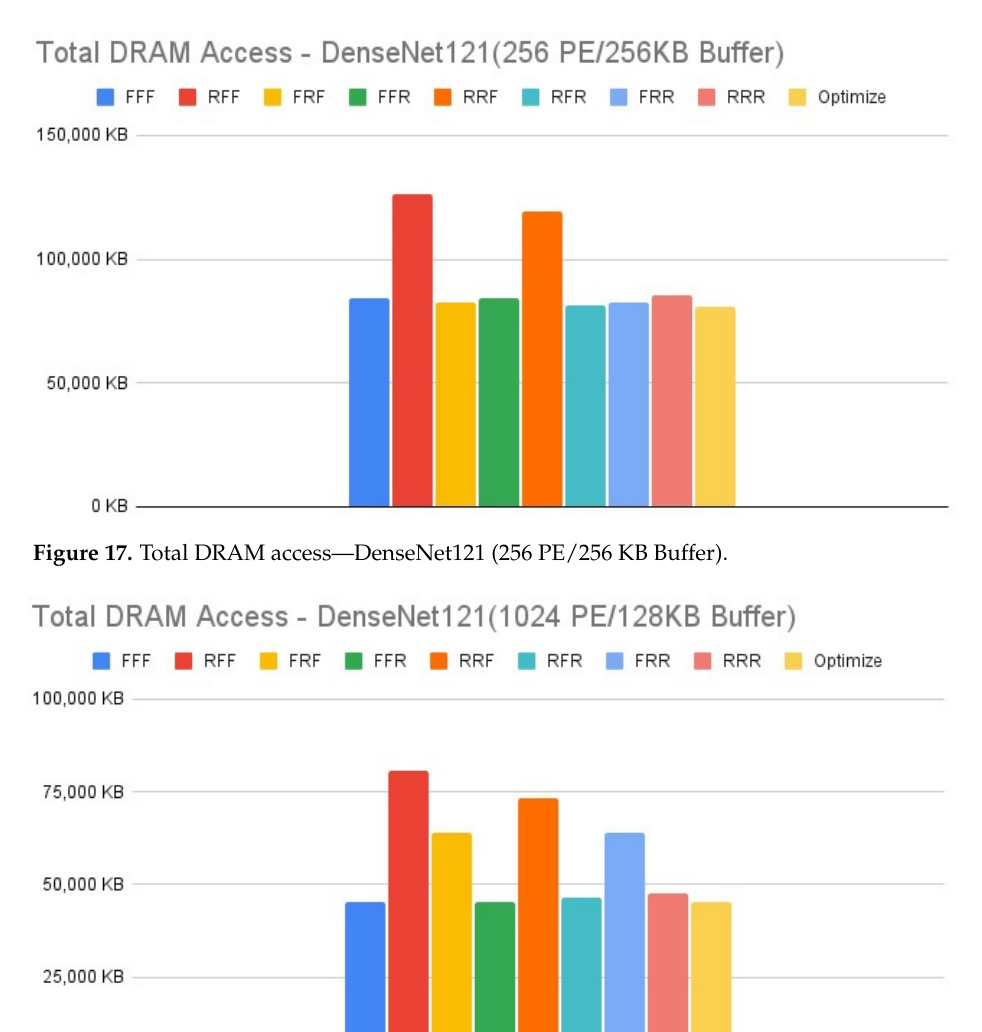
Figure 16. Total DRAM access—DenseNet121 (1024 PE/256 KB Buffer).